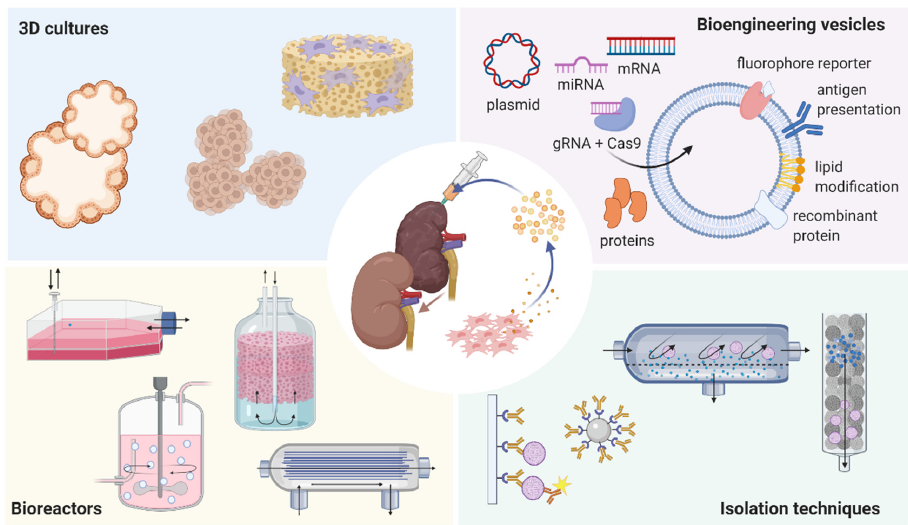
Figure 1. Strategies to support extracellular vesicles production for the treatment of kidney diseases. Approaches to improve the production, isolation and/or efficacy of extracellular vesicles to treat kidney diseases, which include: applications of advanced bioreactors, three-dimensional (3D) cultures such as organoids, improved isolation techniques and use of biotechnology in EV design (image created with BioRender.com (accessed on 07.05.2021)).